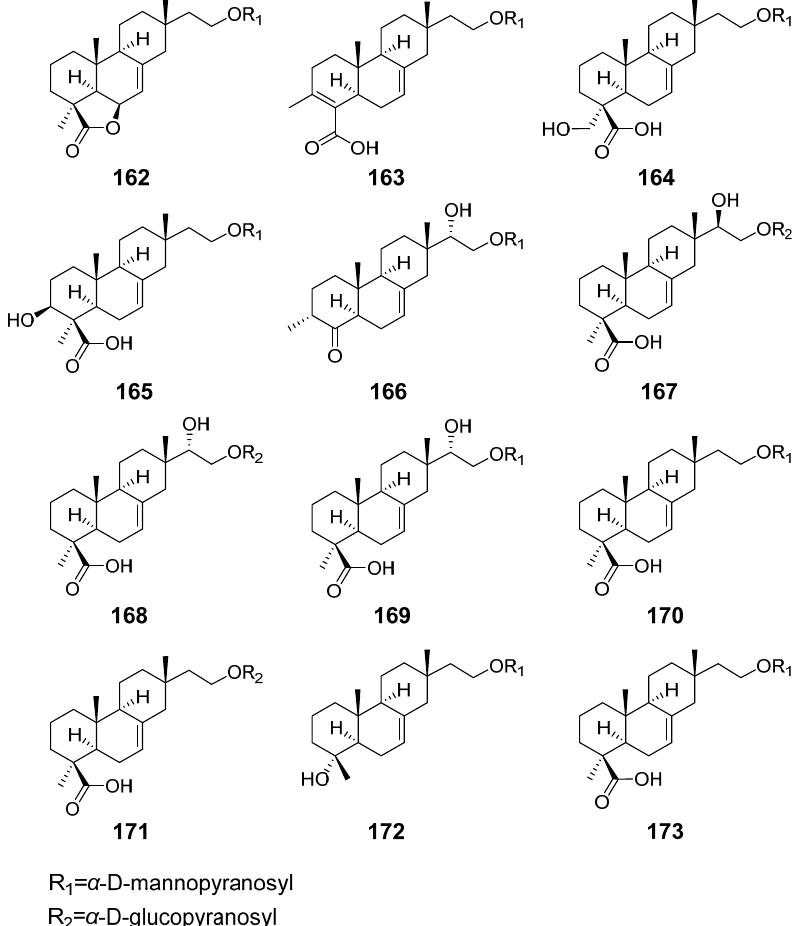
Figure 16. Structures of compounds 162 – 173 .